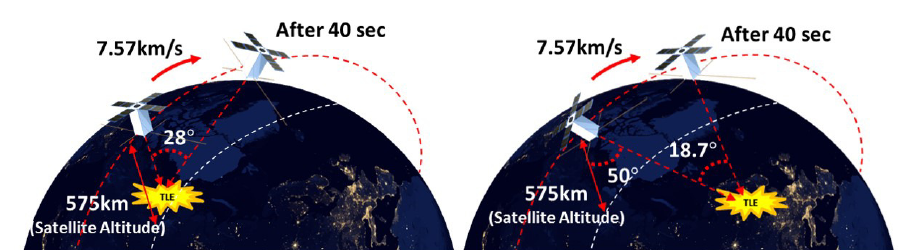
Figure 2. Two possible mission scenarios of the VisionCube to detect TLEs. The left figure shows the case when the VisionCube looks down towards the nadir direction. In contrast, the right figure shows the case when the VisionCube extends the observation area by scanning motion via the roll